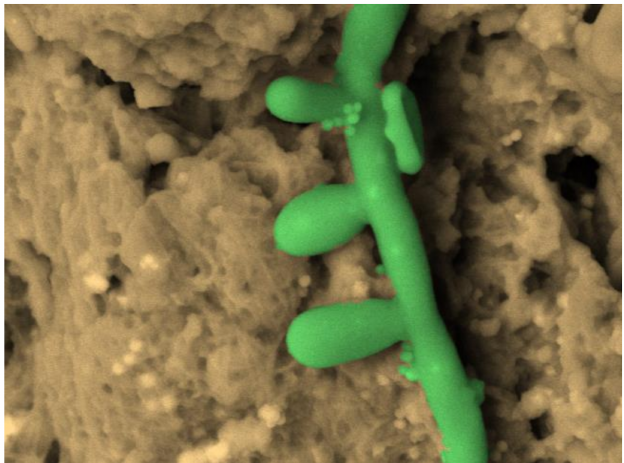
Figure 9. Candida albicans hyphae with conidia and spores, SEM OsO 4 -RR-TA-IL protocol 3000 × , image artificially colored by software 3D Hitachi Mountains Map (Digital Surf, France).